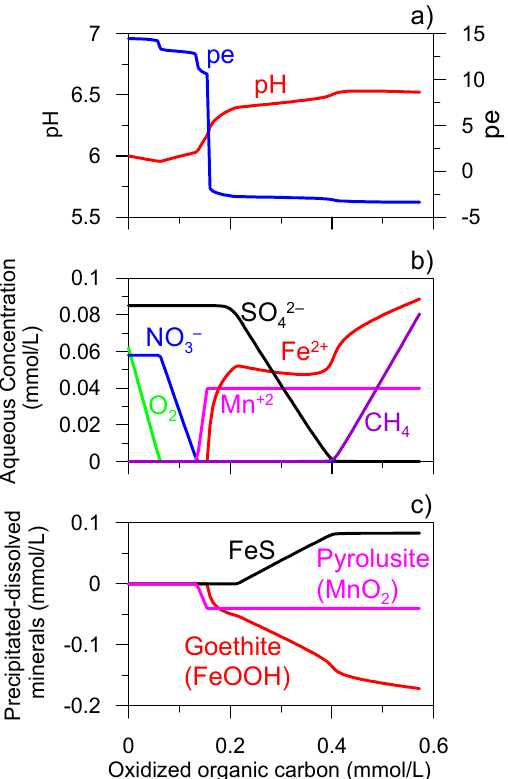
Figure 13. Example of the effect of organic carbon oxidation on groundwater chemistry (a and b) and mineralogy (c). Organic carbon is added stepwise and is oxidized assuming equilibrium for all reactions. Details of the model are given by Appelo and Postma ([51], example 9.6).